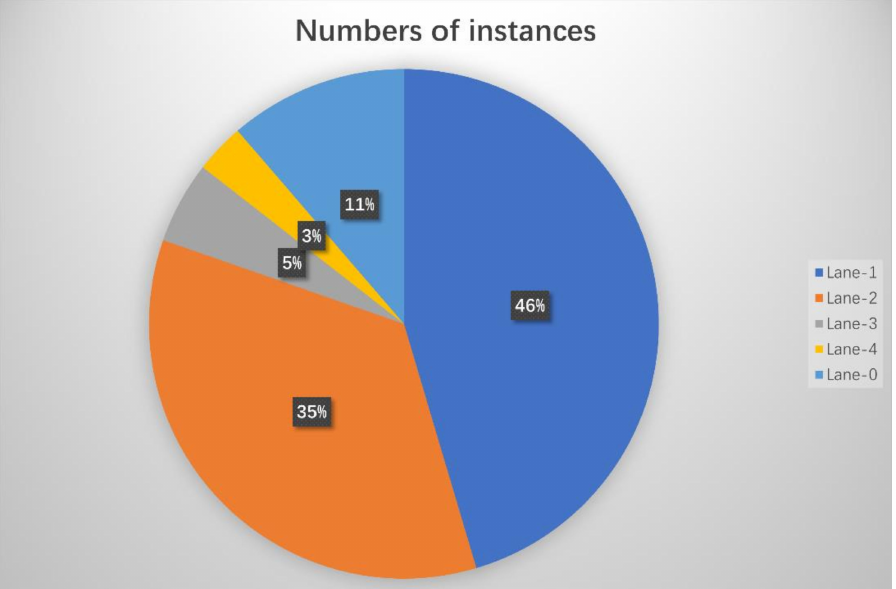
Figure 5. Instances distribution in the